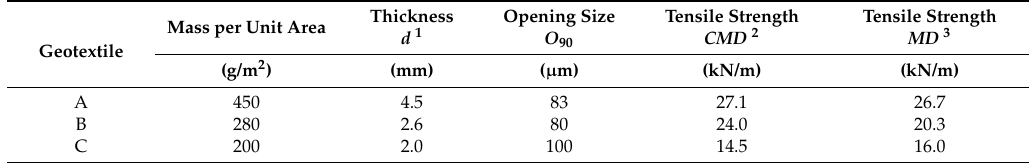
Table 1. Physical and mechanical properties of the tested nonwoven geotextiles.